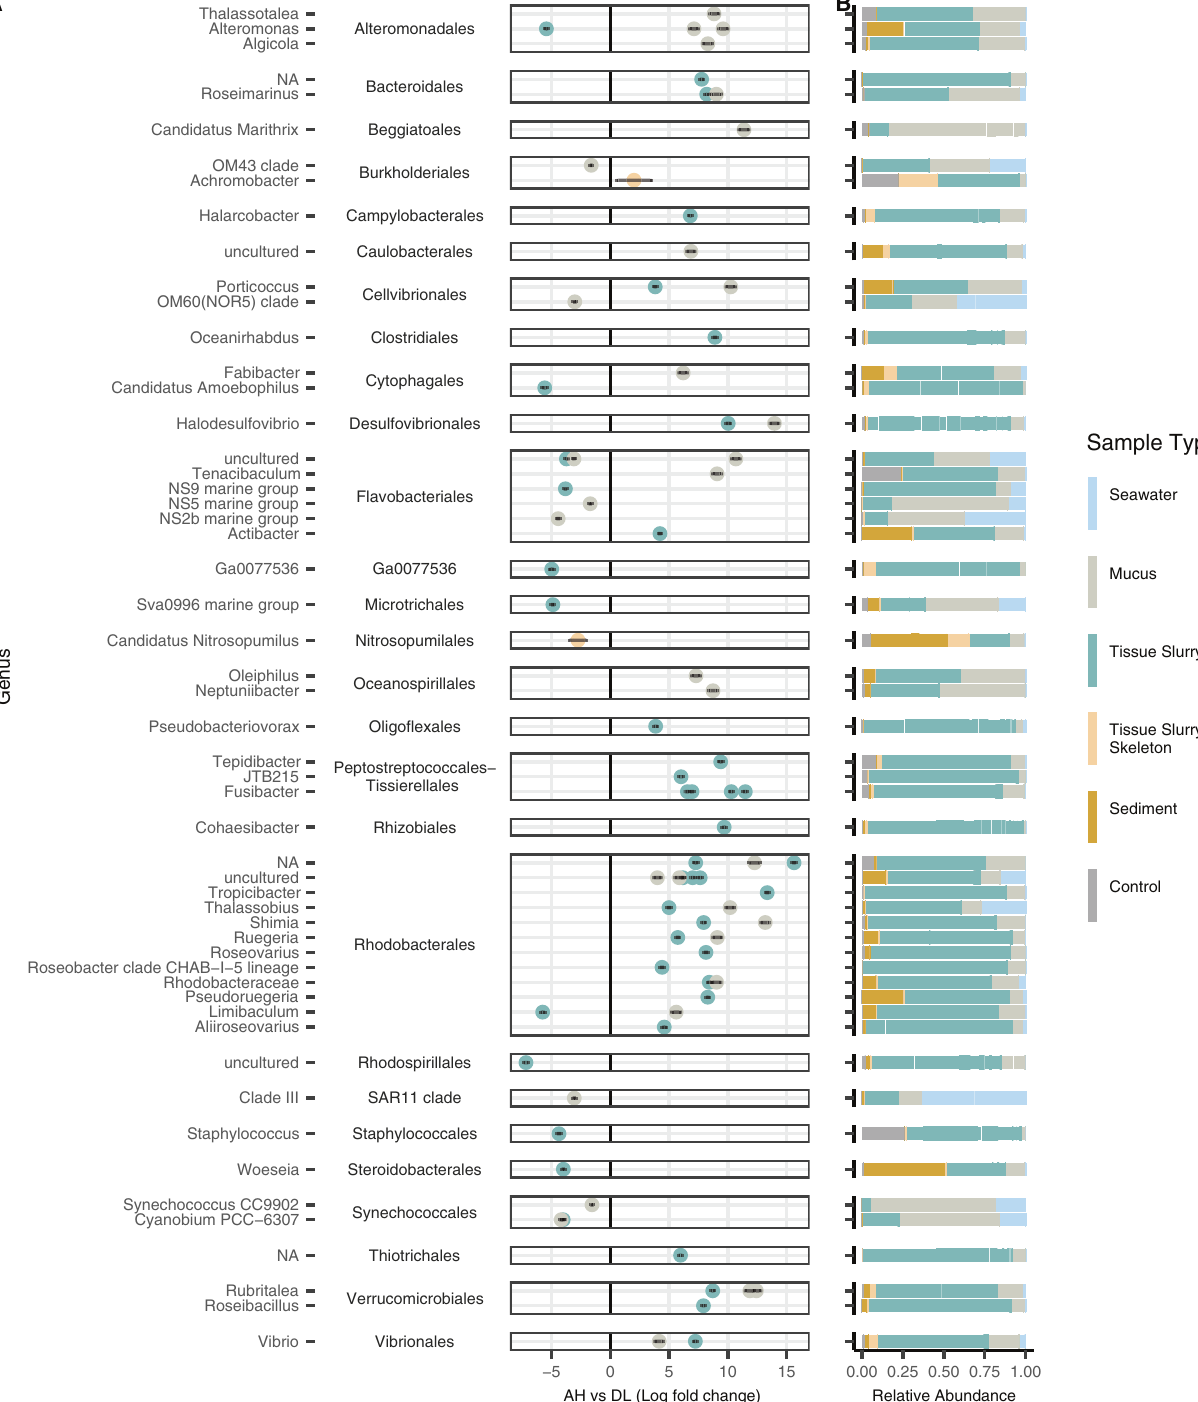
Fig. 6 Microbial amplicon sequence variants (ASVs) associated with lesions on diseased colonies (DL). Differential abundances between ( A ) apparently healthy (AH) vs DL. The y axis depicts ASVs grouped by genus and then by order. Only ASVs with a P adj < 0.001, W statistic >90, and a log-fold change < − 1.5 and >1.5 were visualized. Coral compartments (i.e., mucus, tissue slurry, and tissue slurry skeleton) were included and Acropora spp. were excluded from this analysis. B The relative abundance of taxa enriched in AH and DL by sample type, which includes laboratory controls ( “ Control ” ) encompassing fi eld, lab, kit, and mock DU and six in DL (Supplementary Fig. 11A). The most enriched predictions. There was a total of 6307 differently abundant pathway in DU was 4-hydroxybutyrate dehydrogenase (effect ( P adj < 0.05) Kyoto Encyclopedia of Genes and Genomes (KEGG) size = 0.25), and in DL was phospholipase C/alpha-toxin (effect pathways identi fi ed across AH ( n = 2482), DU ( n = 1403), and DL size = 0.97). A total of 392 differentially abundant MetaCyc ( n = 2422). Of the top ten KEGG pathways, three were enriched in